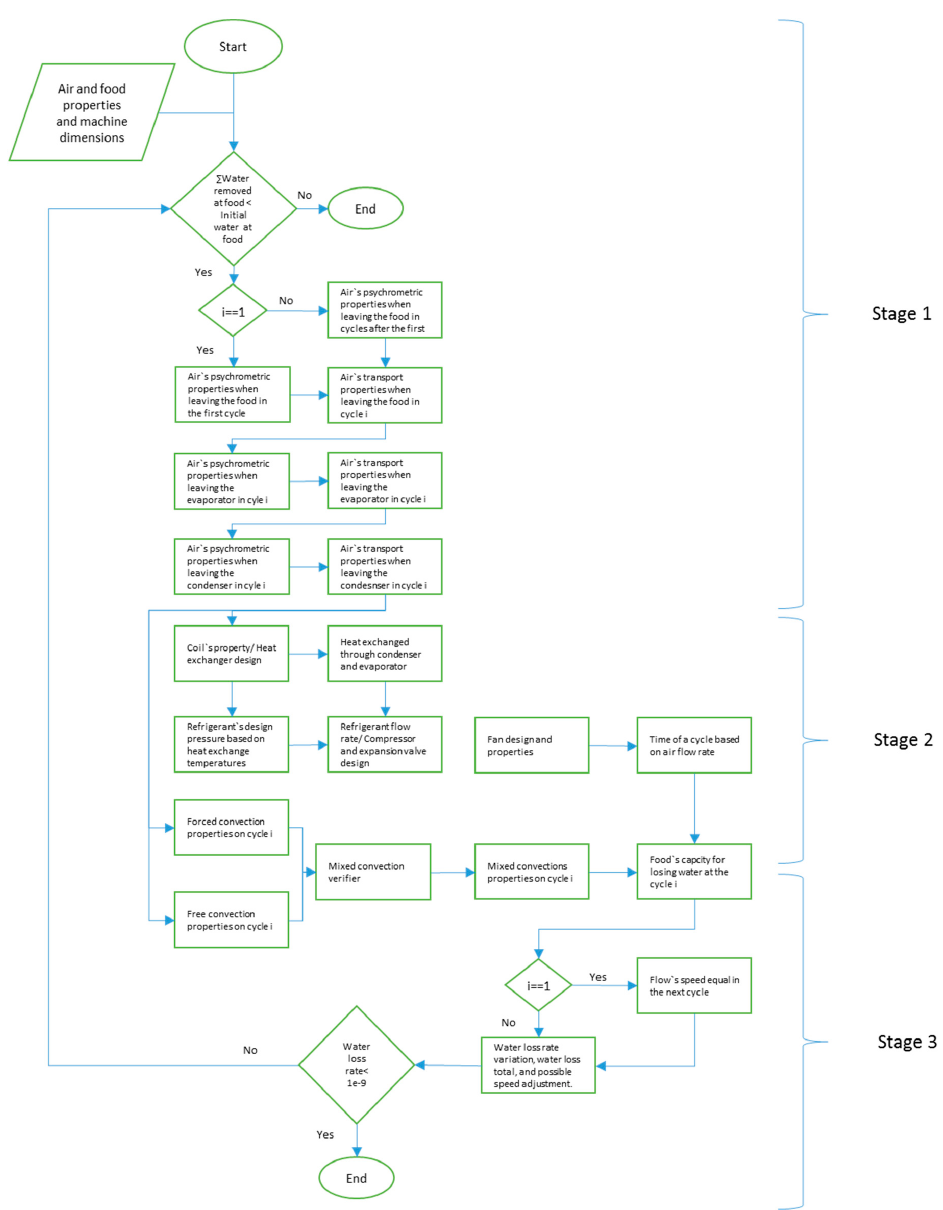
Figure 5. Heat pump dryer design optimization